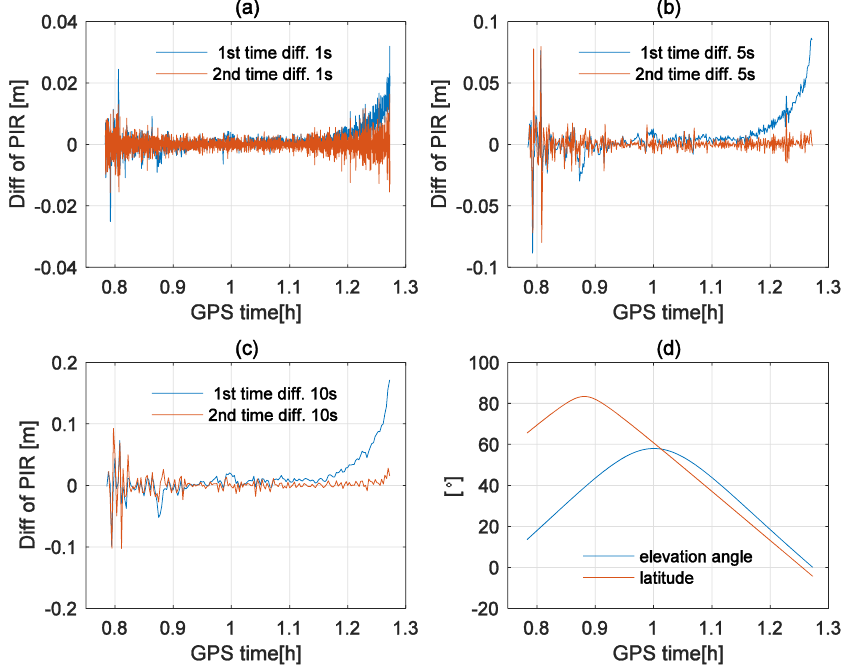
Figure 5. Time-difference PIR, elevation angle, and satellite latitude for GPS PRN 19 at GOCE on 26 November 2009, with different sampling intervals. ( a – c ) First- or second-order time-difference PIRs for 1 s, 5 s, and 10 s, respectively; ( d ) GPS satellite elevation angle and GOCE satellite latitude.